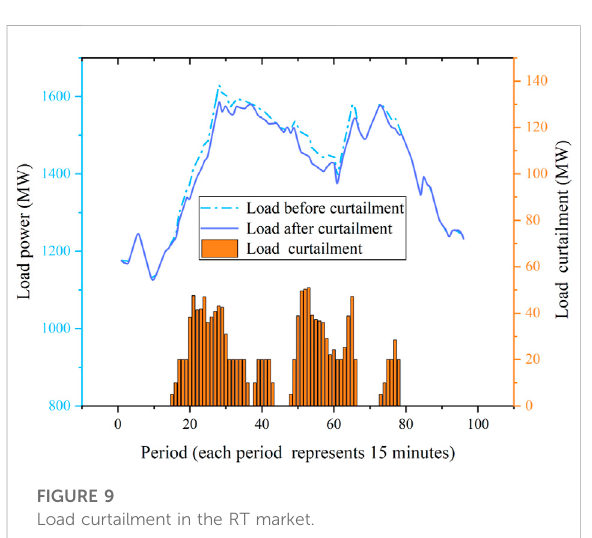
FIGURE 9 Load curtailment in the RT market.